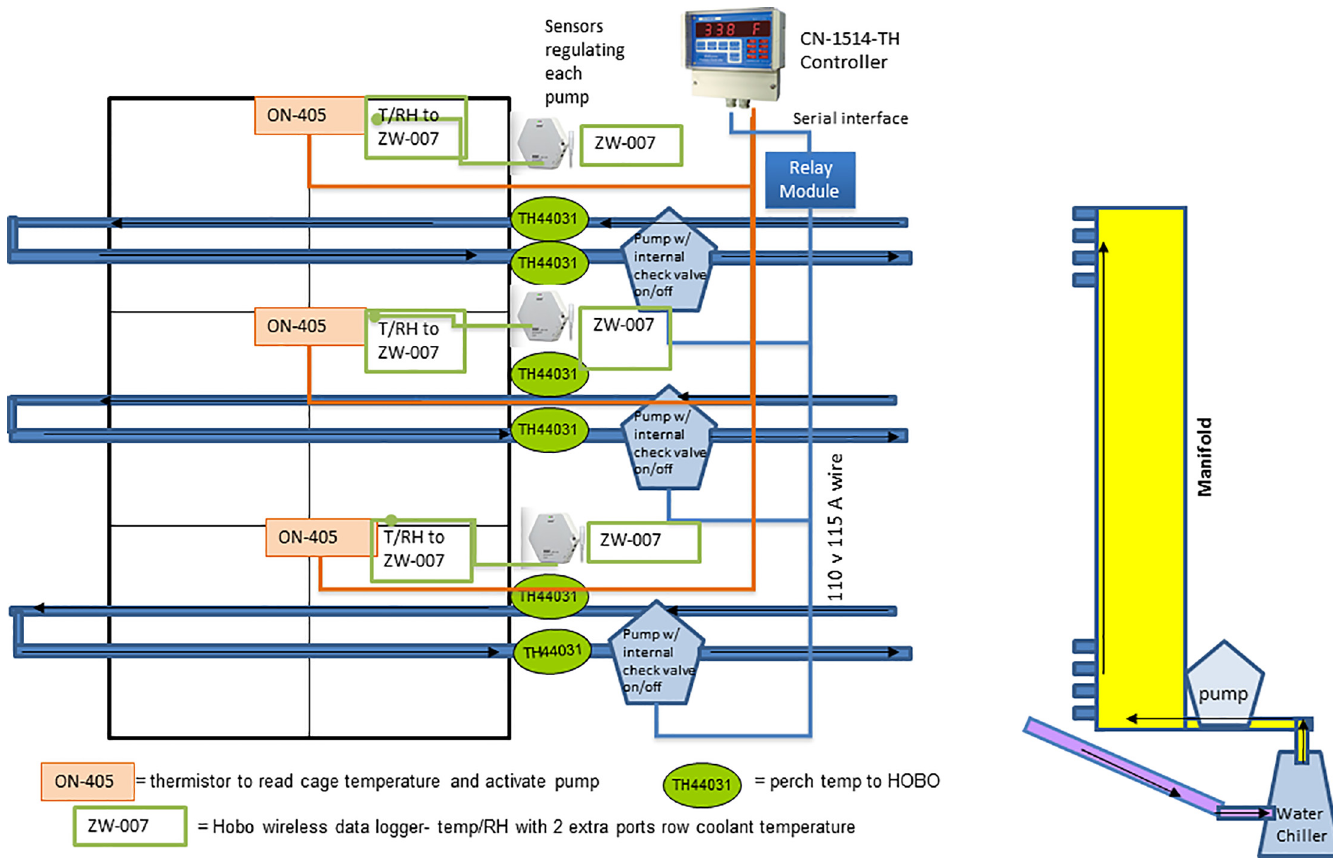
Fig 1. The bank of cages assignment for the thermally cooled perch treatment. Each tier had its own pump to distribute chilled deionized water (110°C) through its perch loop that ran parallel to the feeder. The front perch closest to the feeder received chilled water pumped directly from a common vertical manifold. The back perch was the return loop that sent the water back to the common manifold to be re-chilled. A chiller was used to cool the water in the manifold; it had its own independent thermostat which kept the water at 10°C. A separate 4th pump continuously circulated the deionized water between the water chiller and the manifold. A sensor for monitoring air temperature was installed to the controller of each tier to activate or stop the circulation of chilled water through the perch loop when ambient temperature reached or fell below 25°C, respectively